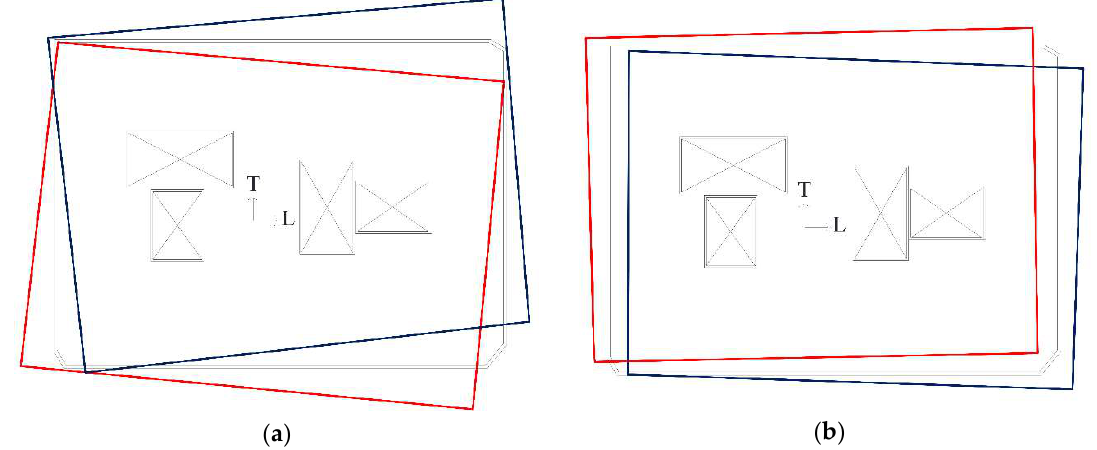
Figure 19. Modal shapes of the first ( a ) and second ( b ) modes of the “La Viña” building, corresponding to a frequency of 2.49 and 2.79 Hz, respectively, determined by the particle motion method. The blue and red lines indicate the positive and negative maximum acceleration of one vibration cycle.